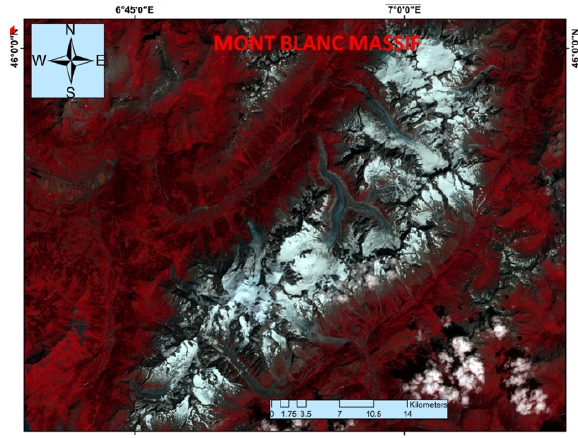
Figure 1. Mont Blanc Massif (Sentinel 2 FCC)